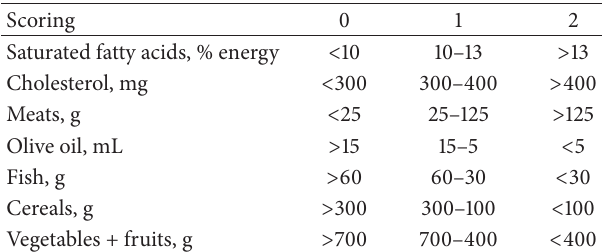
Table 1: Construction of the score for the Mediterranean dietary quality index (lower score indicates higher quality of regimen).